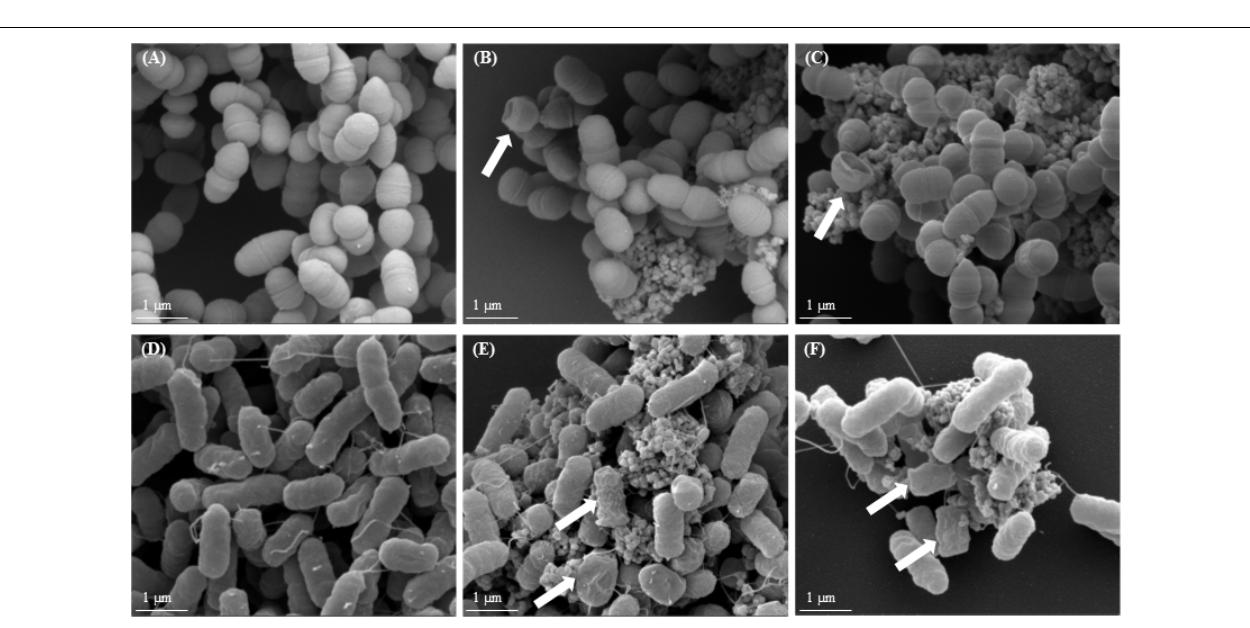
FIGURE 3 | Viability of bacterial cells after TiO 2 exposure. Viable counts (in % of the control) of L. lactis IBB477 (A) and E. coli K12 MG1655 (B) subjected to TiO 2 at 320 µ g/mL in its dispersed form D for food-grade E171 (light orange) vs. TiO 2 -NPs P25 (light green), and sampled at the end of the culture. Data are the means ± SEM. Significance was determined using one-way ANOVA corrected for multiple comparisons with Dunnett test: ( ∗ ) indicates p < 0.05 compared to control conditions with no TiO 2 added.